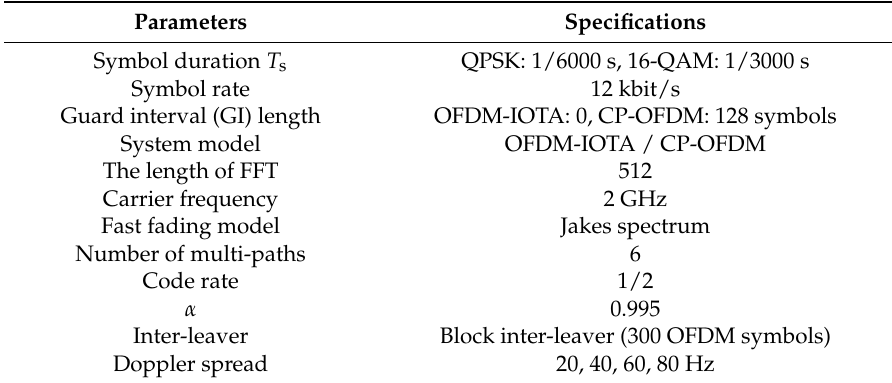
Table 3. Main simulation parameters in this